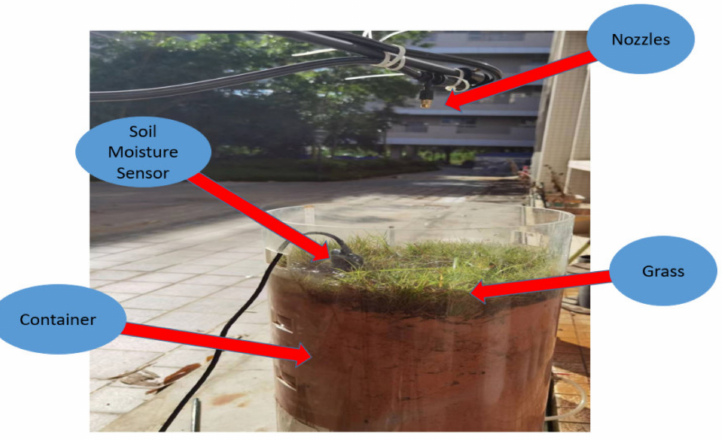
Figure 24. Experimental